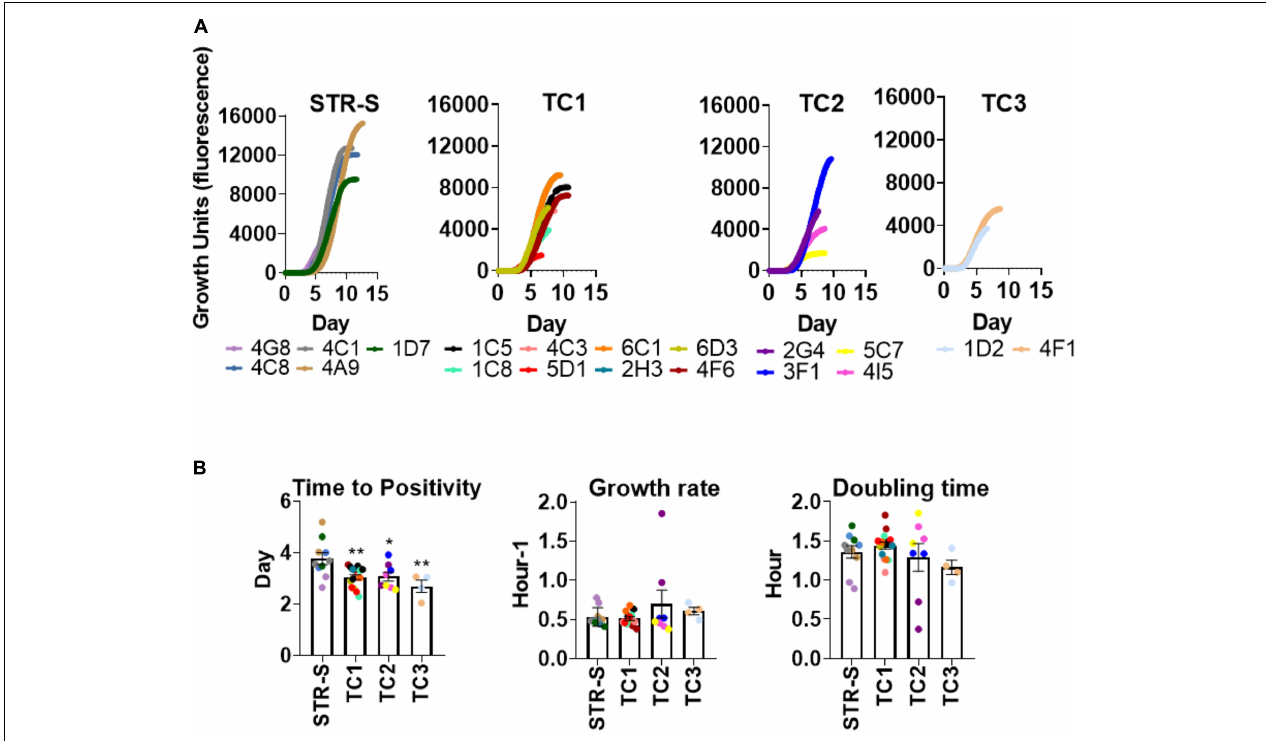
FIGURE 2 | In vitro growth comparison of STR resistant and susceptible Mycobacterium tuberculosis clinical isolates. (A) Growth of M. tuberculosis isolates in MGITTM 960 tubes. Each curve illustrates the average growth of the isolate inoculated in the MGIT culture media, two replicates were included. STR-S,